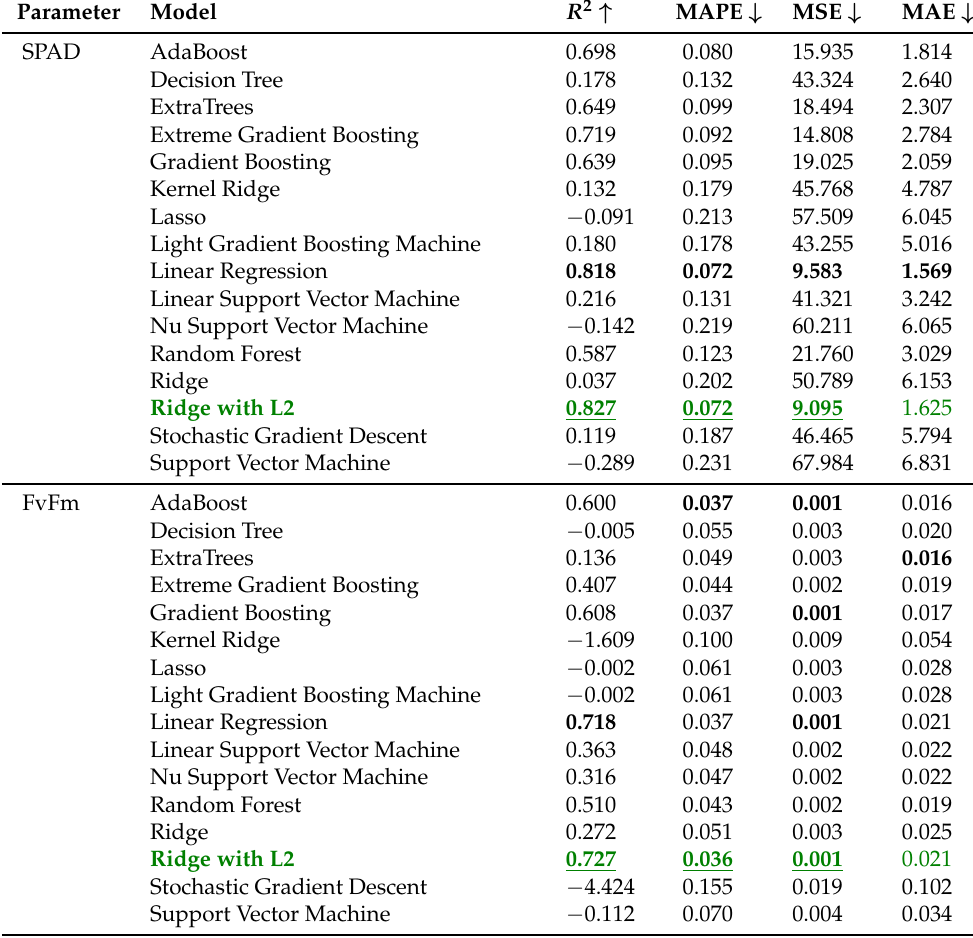
Table 7. Performance of the investigated machine learning models for each chlorophyll-related parameter of interest. The best results obtained using the baseline machine learning models are boldfaced in black , whereas the model with further regularization is indicated in green (if it resulted in the best metric value across all models, the values are boldfaced and underlined). We indicate if the metric should be minimized ( ↓ ) or maximized ( ↑